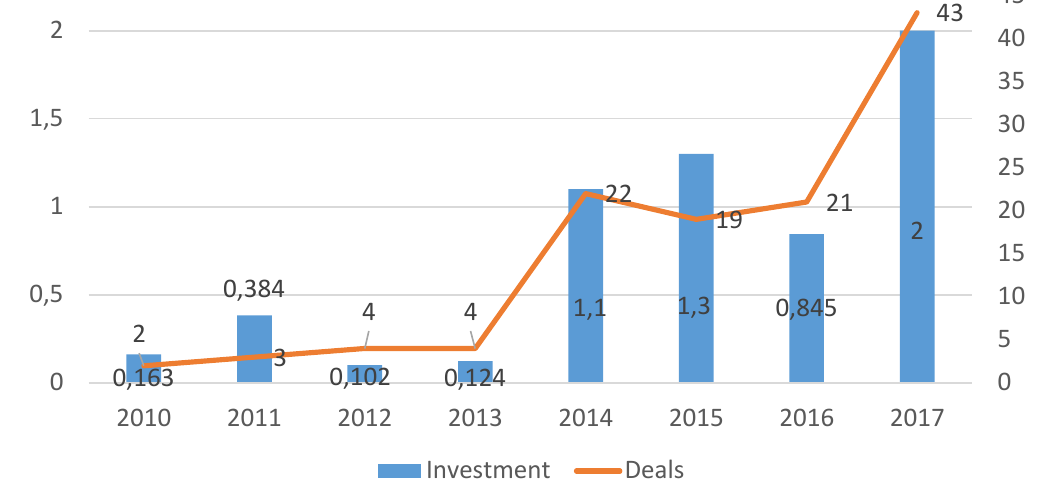
Figure 2. Investments in European FinTech sector, bln. USD